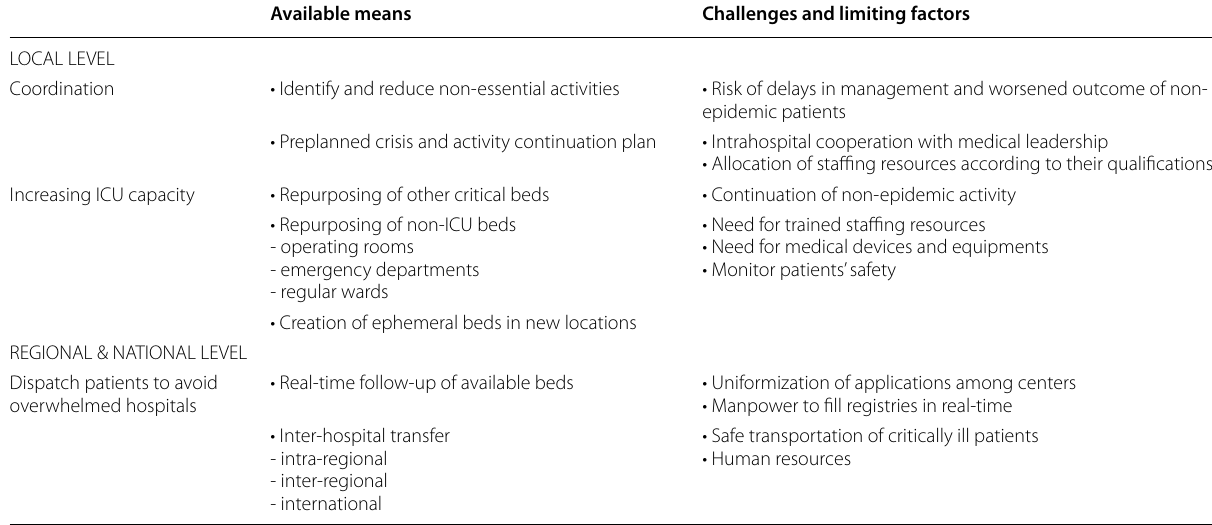
Table 2 Accommodating ICU bed capacities to face a rapid surge of patients Available